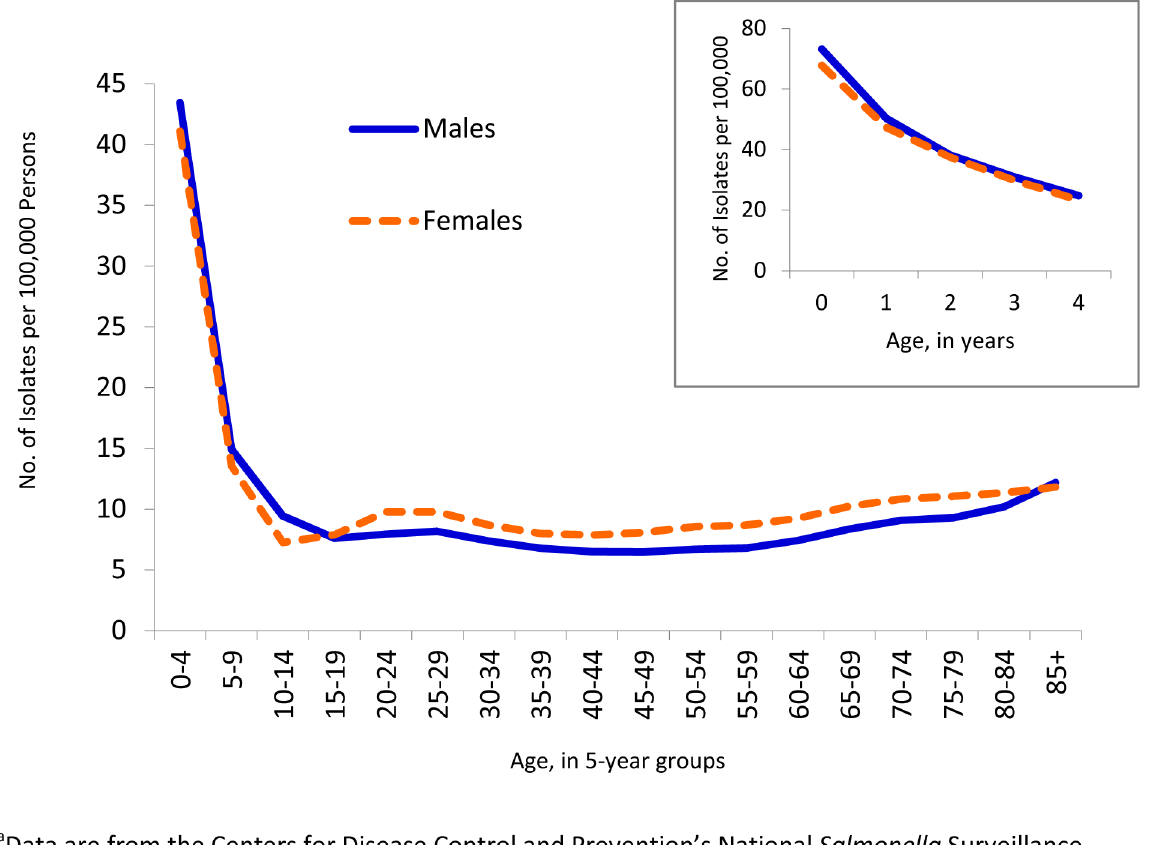
Fig 2. Incidence of Salmonella Isolates from Humans by Age Group and Sex, United States, 1996 – 2011, with Outset Graphs Highlighting 0 – 4 Year- Old